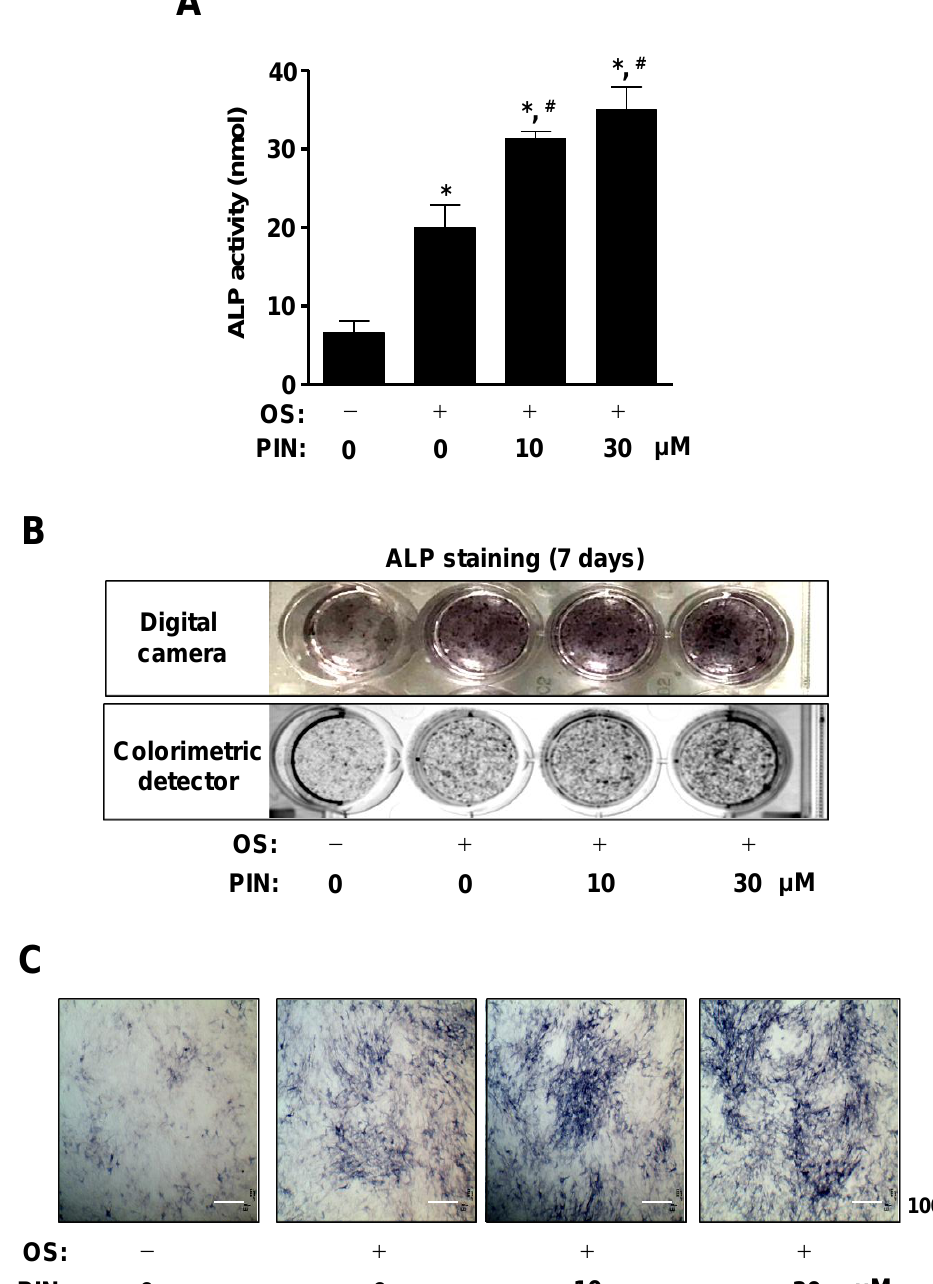
Figure 3. E ff ect of PIN on the staining and activity of ALP during the early di ff erentiation of pre-osteoblasts.( A )Pre-osteoblastswereculturedinOSwith10and30 µ MPINfor7days. The enzymatic activity of alkaline phosphatase (ALP) was measured at 405 nm using a spectrophotometer. ( B , C ) 7 days after osteoblast di ff erentiation, ALP staining was detected by using a digital camera (upper) and colorimetric detector (bottom) ( B ), and ALP-positively-stained cells were also observed under a light microscope ( C ). Scale bar: 100 µ m. Data represent the mean ± S.E.M. of experiments. *, p < 0.05 indicates statistically significant di ff erence, compared with the control. #, p < 0.05 indicates statistically significant di ff erence when compared with